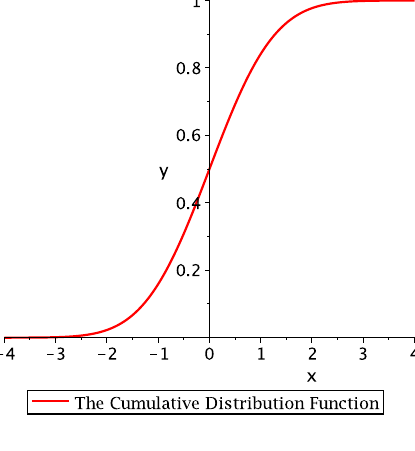
Figure 4: CDF normal (6) , with σ = 1 and µ = 0